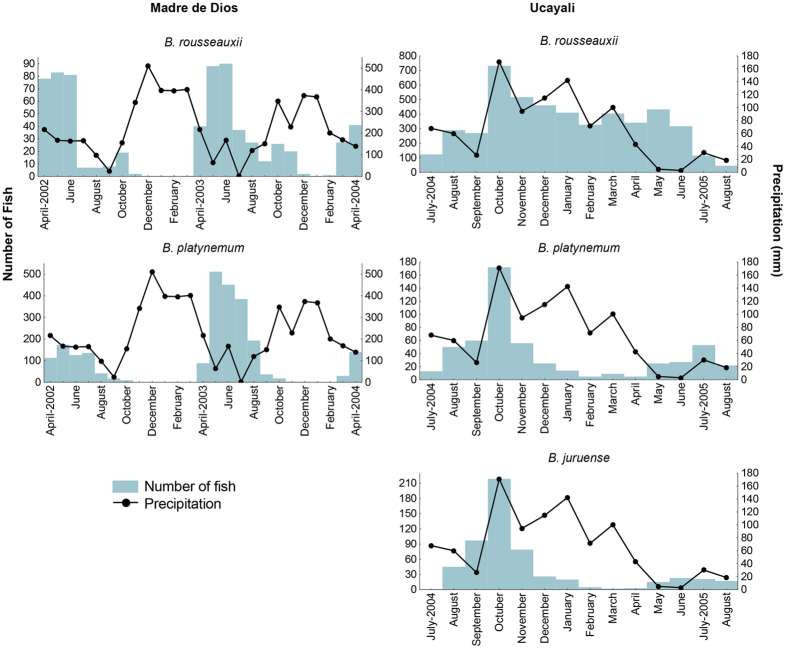
Mature goliath catfish from commercial catches near the Andes indicate the presence of spawning populations.Monthly precipitation and monthly capture of mature B. rousseauxii, B. platynemum, and B. juruense between April 2002 and April 2004 in Puerto Maldonado (Madre de Dios River, Upper Madeira Basin) and between July 2004 and July 2005 at Atalaya (near the confluence of the Ucayali and Urubamba Rivers). B. juruense was not captured in the Madre de Dios River during our study period. Precipitation was used as a proxy for river level since there were few data for the latter in the Andean region.